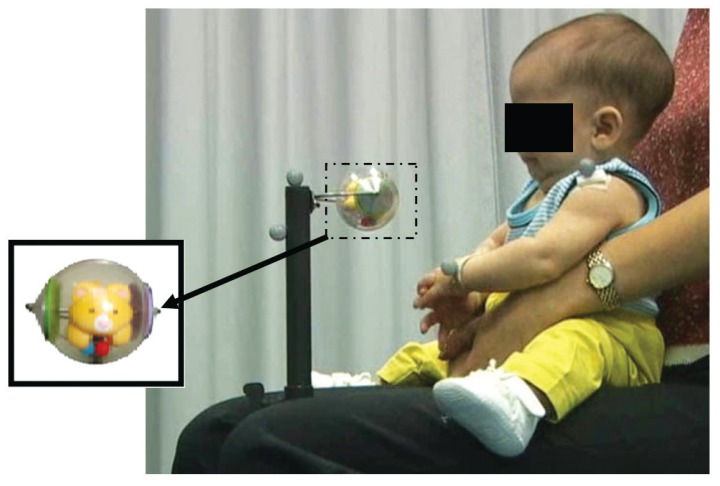
Infant positioned during the manual function evaluation with the object
expanded.